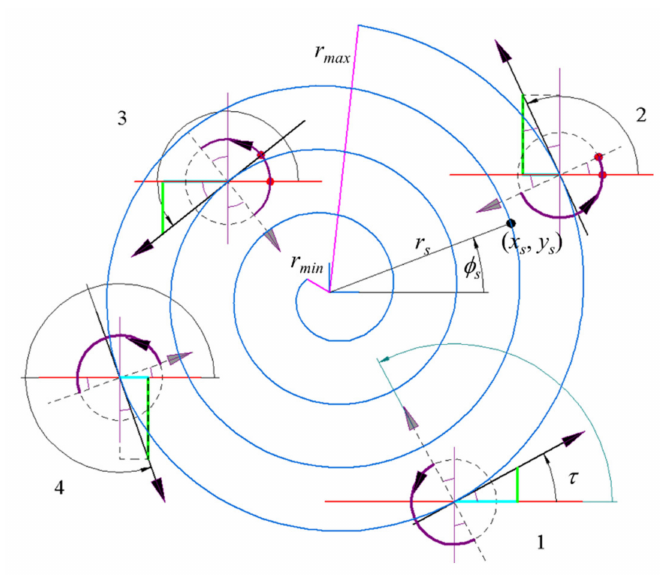
Figure 16. Rotation and translation for adapting the point ( x i , y i ) to the spiral